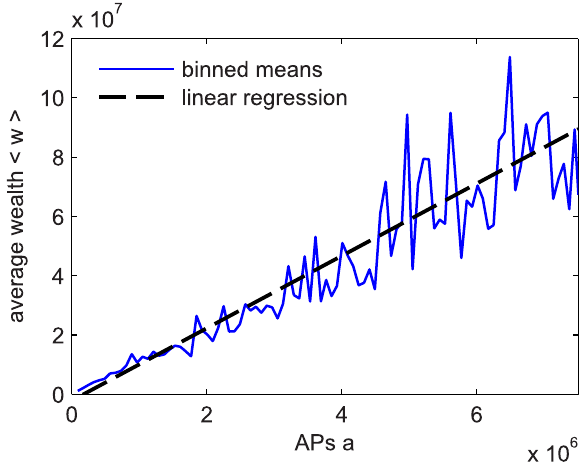
Figure 3. Wealth as a function of activity a . The blue line shows binned averages of wealth. The dashed line is a linear regression, with a slope 12 : 2 credits/AP and a corresponding Pearson correlation coefficient r w , a ~ 0 : 535 . Data are taken for all active players on day 1200.